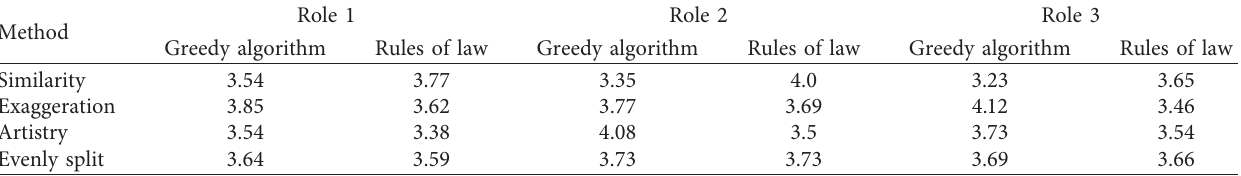
Table 2: Comparison table of result evaluation